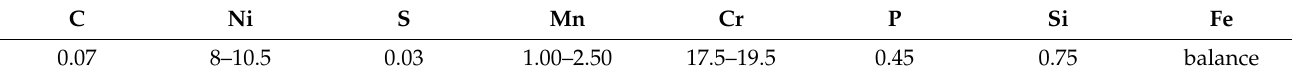
Table 2. ER304 welding wire chemical composition table (mass fraction, %).